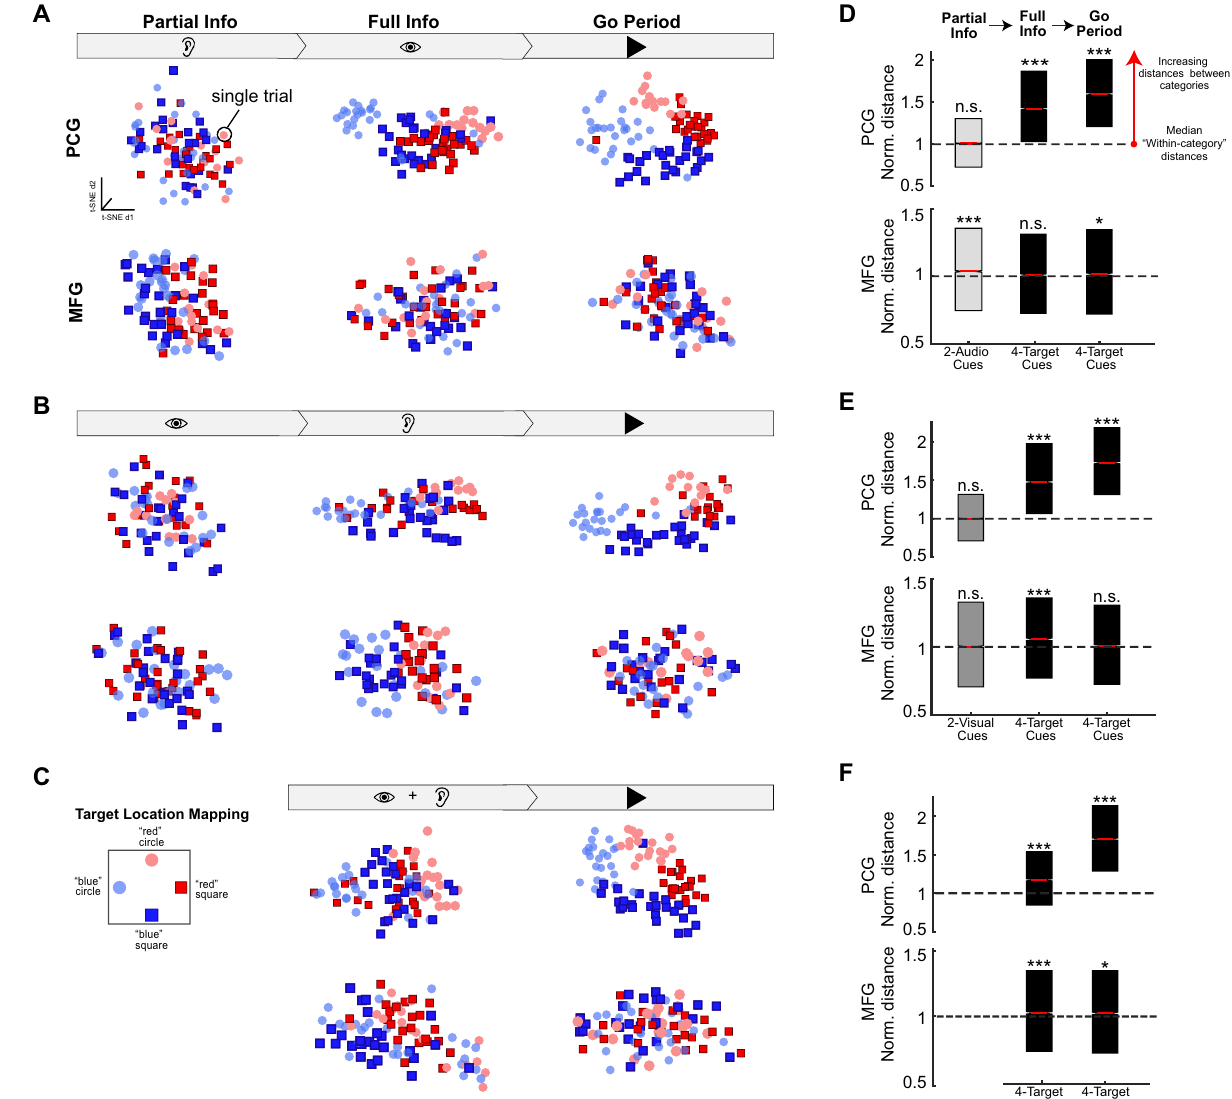
Figure 3. Spike train similarity analysis reveals that MFG displays distinct, recurring single trial activity patterns in response to partially informative auditory cues, while movement-specific activity emerges in PCG only after targets have been unambiguously specified. Spike train similarity space (SSIMS) representation of PCG ( top row ) and MFG ( bottom row ) ensemble spiking responses (one session, day 356) during the presentation of the target-related auditory cues ( ear symbol ), target-related visual cues ( eye symbol ), and the audio-visual go cue ( black triangle ) in the AV task ( A ), the VA task ( B ), and the A + V task sequences ( C ). Each data point represents the ensemble spiking pattern on a single trial and the distance between points corresponds to the degree of dissimilarity between the ensemble spiking pattern on those trials. The shape and color of each data point indicates which visual cue (circle or square) and auditory cue (“red” or “blue) were presented on a given trial (schematic of target locations used for this recording session are shown in C ). ( D-F ) Boxplots show the normalized average distances between different sets of data points in the PCG ( top row ) and MFG ( bottom row ) SSIMS representations during different phases of the AV ( D ), VA ( E ), and A + V ( F ) task sequences (pooled across sessions).The distributions of “Between-category” distances were normalized against the median ( black dashed line ) of the distances between points representing a common category of trials (“Within-category” distances). A KW test was used to assess the statistical significance of any differences among the normalized Within- and Between-category distributions, pooled across sessions ( *, p < 0.05 ; ***, p < 0.001; n.s, not significant, p > = 0.05; see Table 1 for all p -values). Significant distance values above 1 indicate that the average distance between trials from different clusters is larger than the distance between trials within a